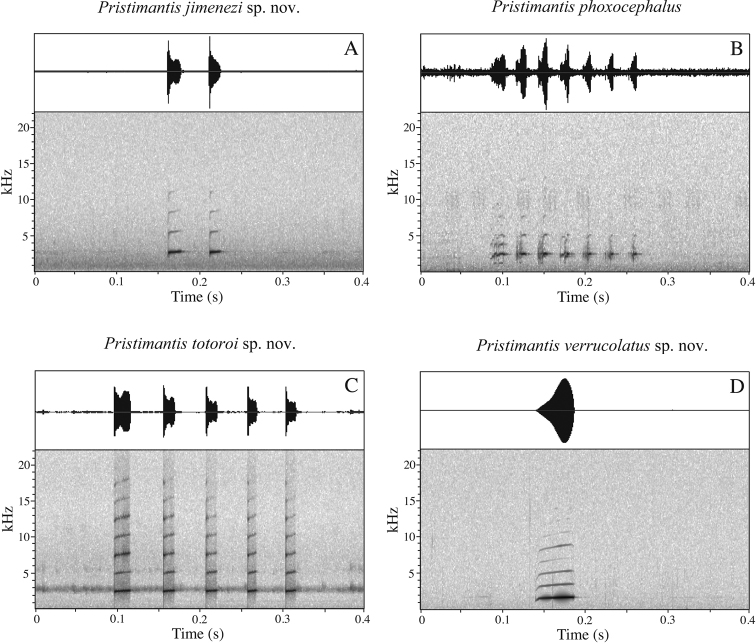
Comparison of advertisement calls of Pristimantis
jimenezi sp. nov., P.
phoxocephalus, P.
totoroi sp. nov. and P.
verrucolatus sp. nov. APristimantis
jimenezi: QCAZ 46977 BPristimantis
phoxocephalus: non-collected individual from Pilaló (type locality). CPristimantis
totoroi: non-collected individual from Cashca Totoras (type locality) DPristimantis
verrucolatus: QCAZ 46981. Oscillograms are shown above spectrograms. X axis for time (s); Y axis for frequency (kHz) in spectrograms.